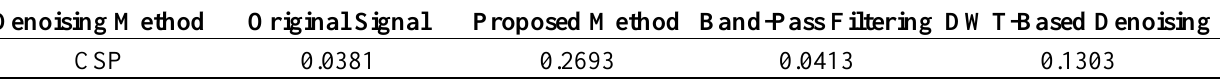
Table 6. The CSP values for the denoising results of different methods for outer-race defective